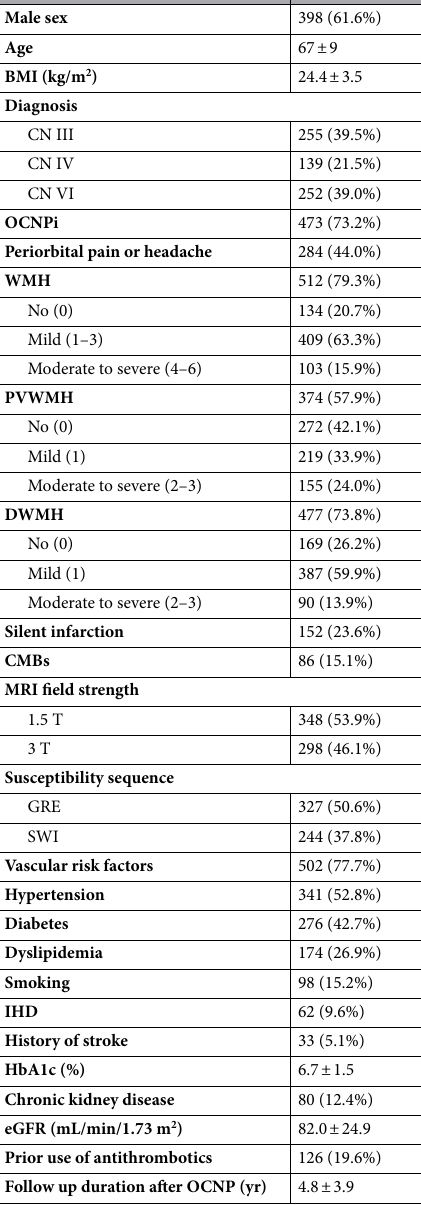
Table 1. Baseline characteristics of the included patients. OCNPi ocular cranial nerve palsy of presumed ischemic origin, BMI body mass index, CN cranial nerve, OCNP ocular cranial nerve palsy, WMH white matter hyperintensities, PVWMH periventricular white matter hyperintensities, DWMH deep white matter hyperintensities, CMBs cerebral microbleeds, GRE T2*-weighted gradient echo, SWI susceptibility weighted image, IHD ischemic heart disease, eGFR estimated glomerular filtration rate, OCNP ocular cranial nerve palsy. Vascular risk factor refers to the presence of at least one of the following: hypertension, diabetes, dyslipidemia, and/or